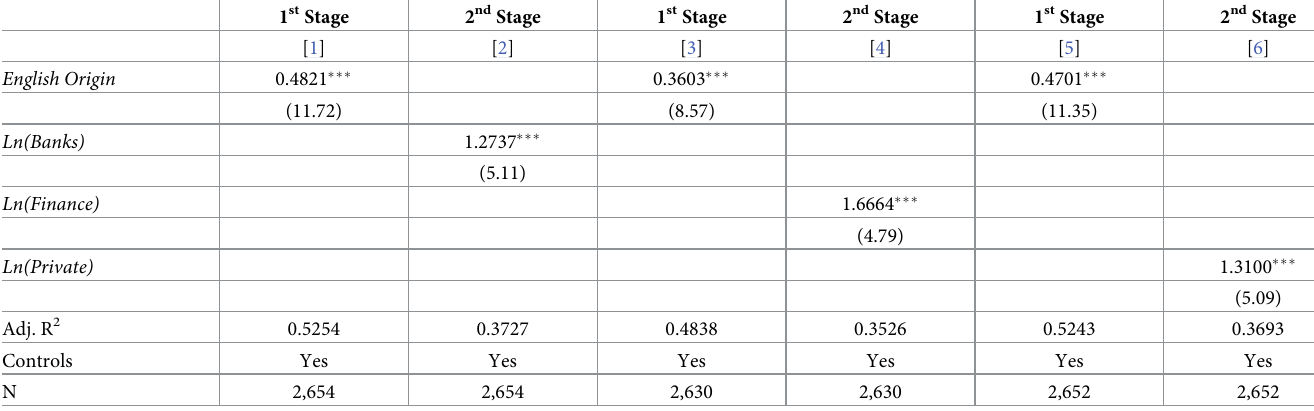
Table 6. Pharmaceutical innovation and credit market development–Instrumental variable